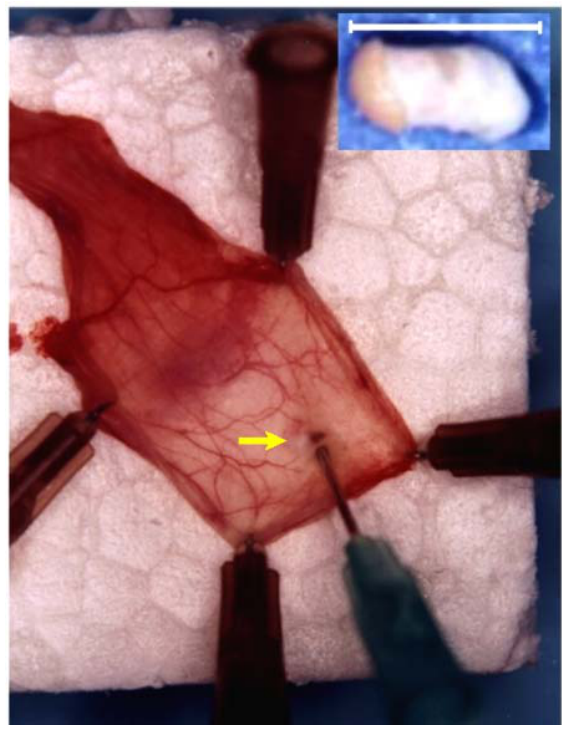
Figure 4 – Preparation of the pouch for histopathological examination. After distending the pouch with needles on the styropor piece, the position of the grafted fragment is marked with a needle different of others (arrow), at distal position, before the graft is undergone formaldehyde. In the detail above, with a white line, the longest ax of the fragment is represented before it is grafted, enfolding epithelium and conjunctive tissue of cutaneous tissue (in this case,